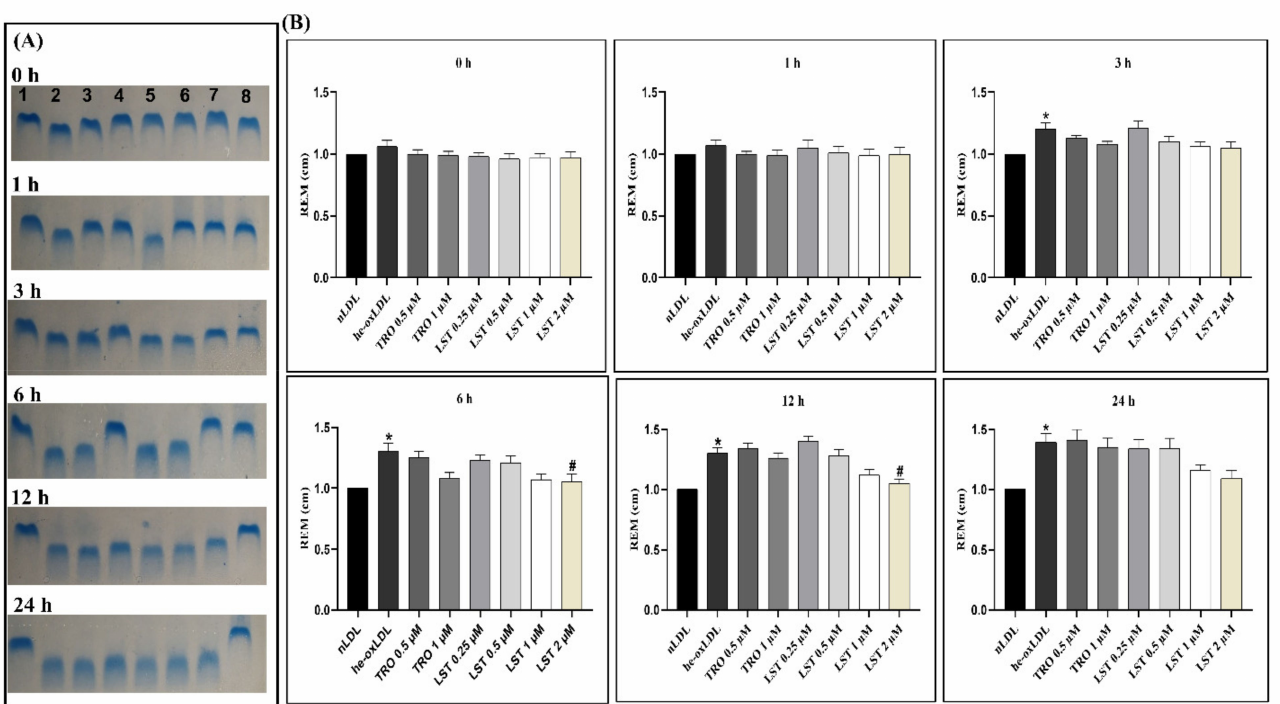
Figure 2. Effect of lusianthridin on relative electrophoretic mobility (REM) in hemin-induced LDL oxidation at various times of incubation. ( A ) Representative REM in agarose electrophoresis. Lane 1: nLDL, lane 2: he-oxLDL, lane 3: trolox 0.5 µ M, lane 4: trolox 1 µ M, lane 5: LST 0.25 µ M, lane 6: LST 0.5 µ M, lane 7: LST 1 µ M, lane 8: LST 2 µ M; ( B ) REM data as mean ± SEMs ( n = 5), * p < 0.05 vs . nLDL; # p < 0.05 vs .